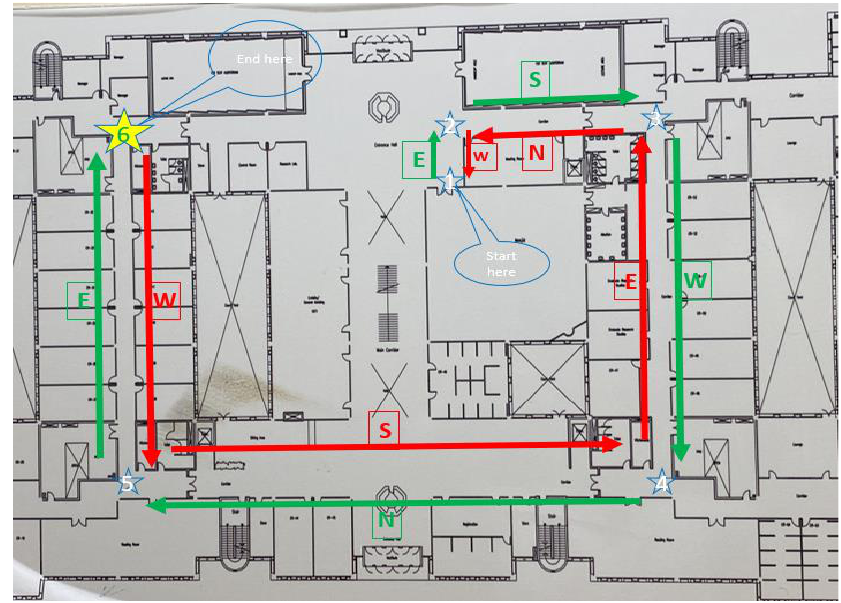
Figure 37. Blueprint of site two (Building 31, King Saud University). Numbers 1 to 6 is locations, letters N, S,W,E is main directions, arrows indicate moving paths.